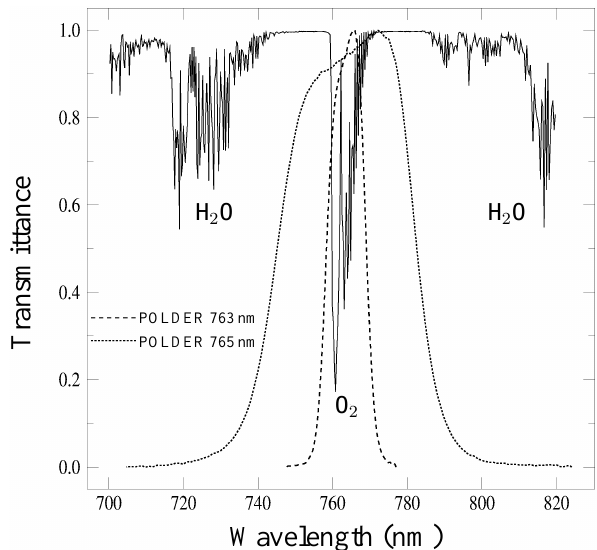
Fig. 1. Atmospheric transmittance in the oxygen A-band region at the resolution of 5cm − 1 ( ’ 0 . 3nm) for an air mass equal to 1 and a Figure 1: Atmospheric transmittance in the oxygen A band region at the res- standard midlatitude summer atmosphere. The filter’s transmissions olution of 5 cm (cid:0) 1 ( ’ 0 : 3 nm) for an air mass equal to 1 and a standard mid- of the two POLDER O 2 bands (centered at 763nm (765nm) with a 10nm (40nm) FWHM) are also given in dashed latitude summer atmosphere. The (cid:12)lter’s transmissions of the two POLDER O 2 bands (centered at 763 nm (resp. 765 nm) with a 10 nm (resp. 40 nm) FWHM) are also given in dashed lines.